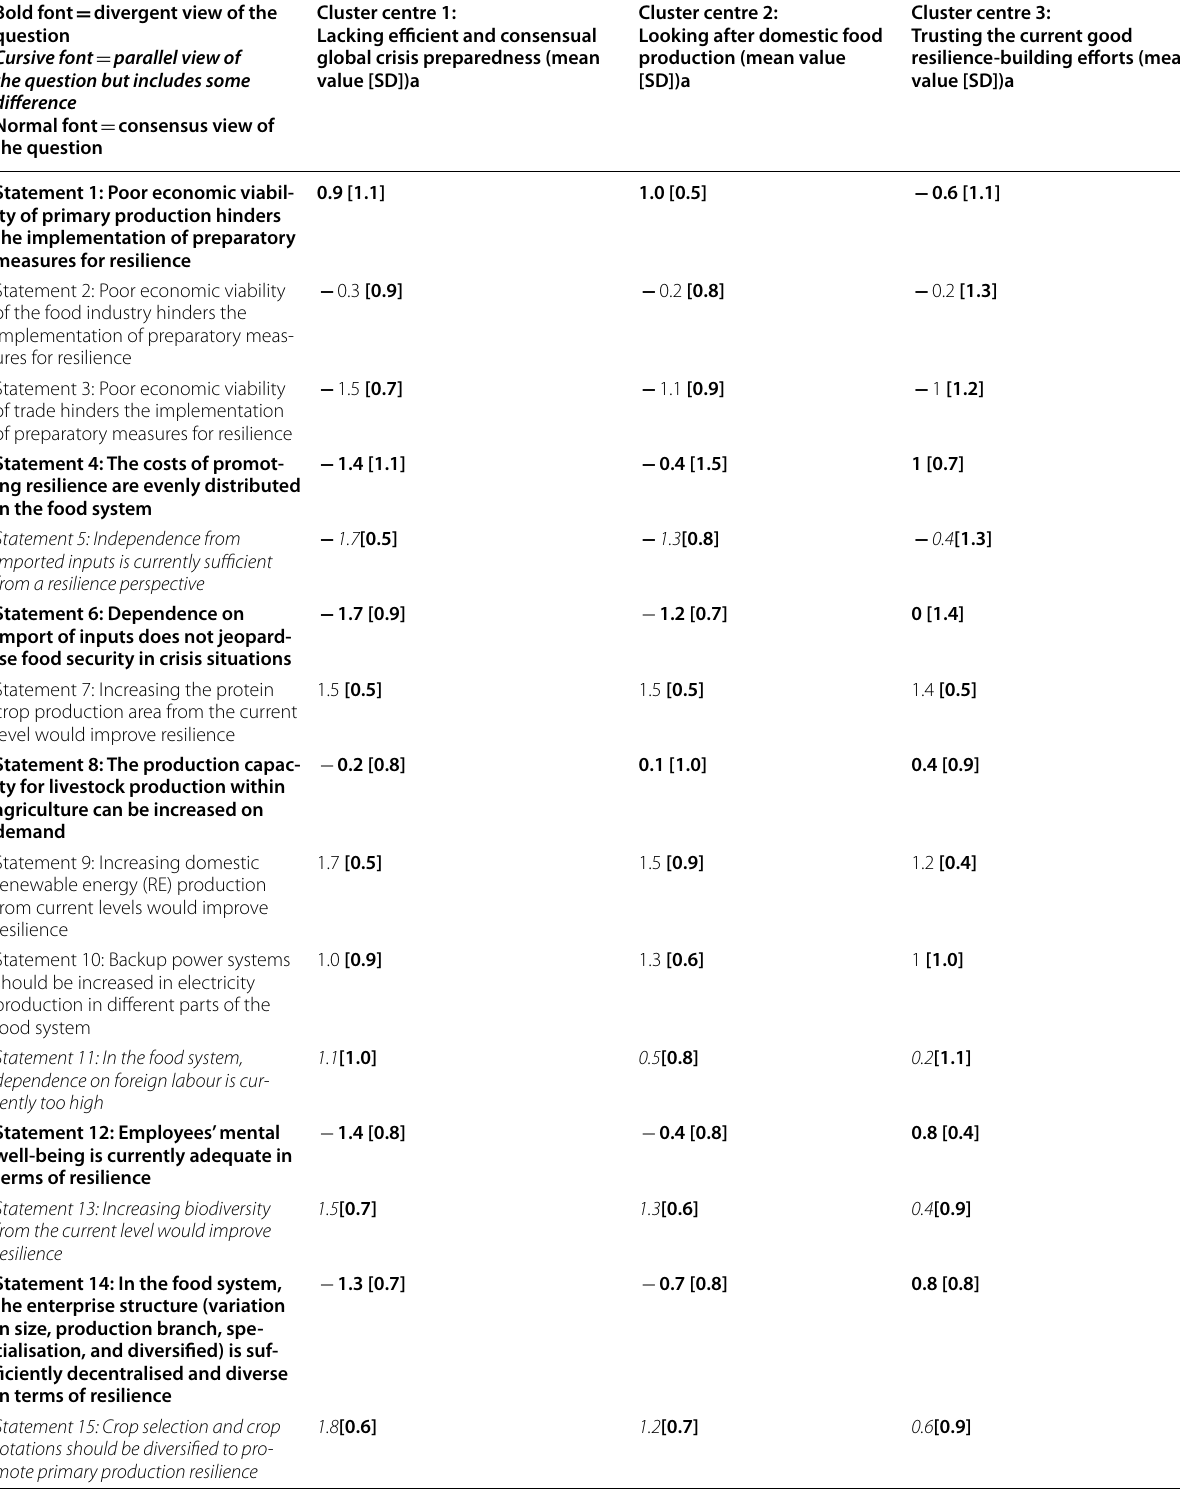
Table 1 Statements and three cluster centres related to determinants, drivers, and changes of a resilient food system Bold font divergent view of the =